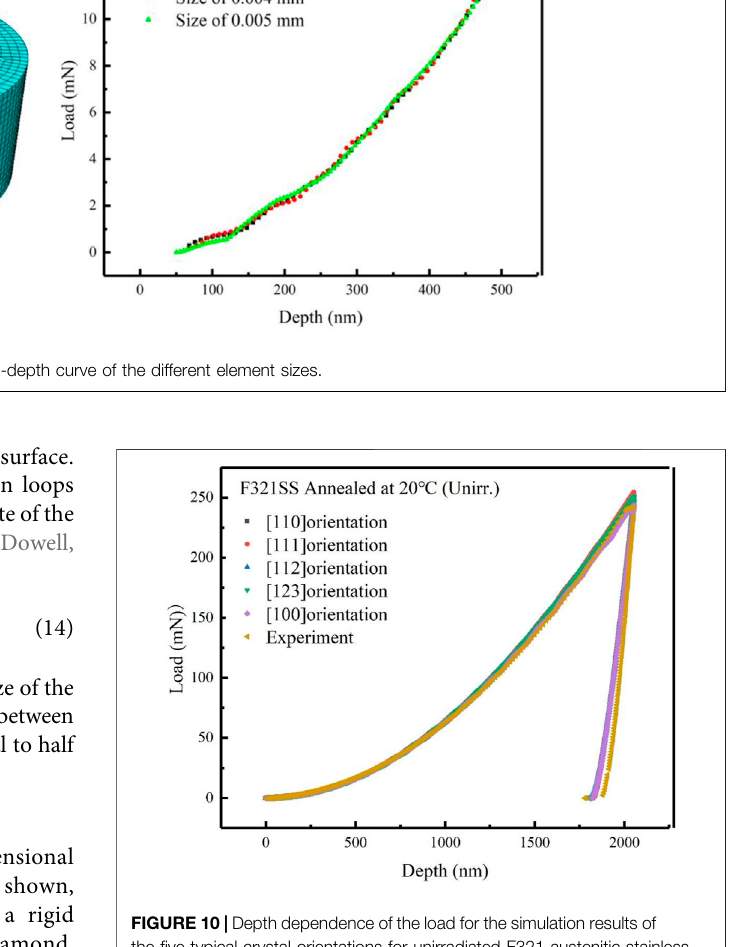
FIGURE 10 | Depth dependence of the load for the simulation results of the fi ve typical crystal orientations for unirradiated F321 austenitic stainless- steel at 20 °